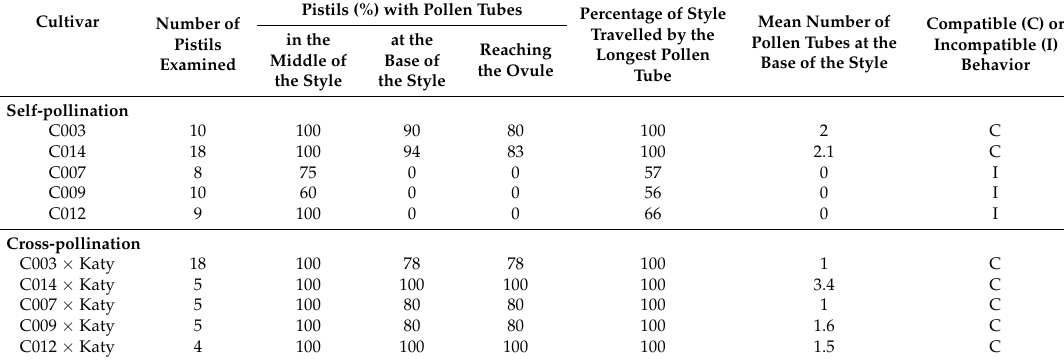
Figure 3. Pollen tube growth in apricot pistils. ( A ) Pollen tube arrested in the upper half of the style in a self-incompatible cultivar; ( B ) Pollen tubes growing along the style; and, ( C ) Pollen tubes at the base of the style in a compatible cross. Scale bars, 100 µm. Table 3. Pollen tube behavior in the pistils of five apricot selections after self- and